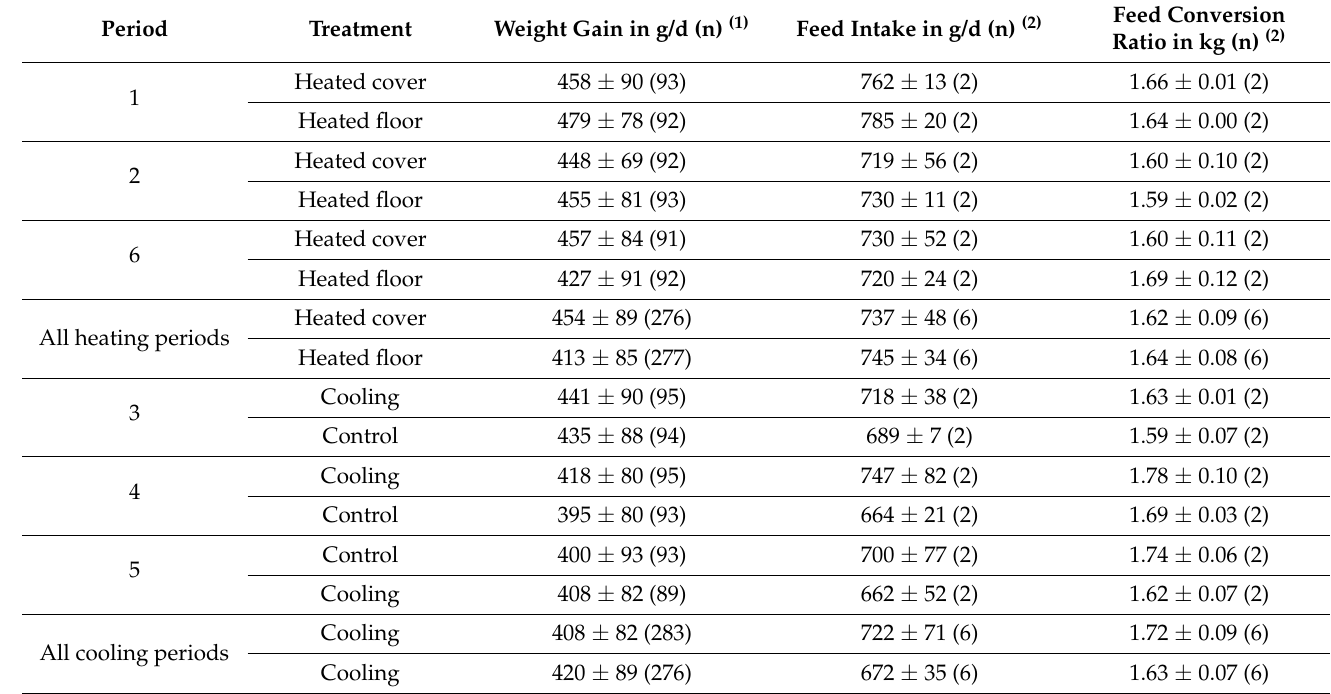
Table 4. Average daily weight gain ( ± standard deviation), feed intake, and feed conversion ratio for each rearing period and treatment. (n) = number of piglets, respectively,